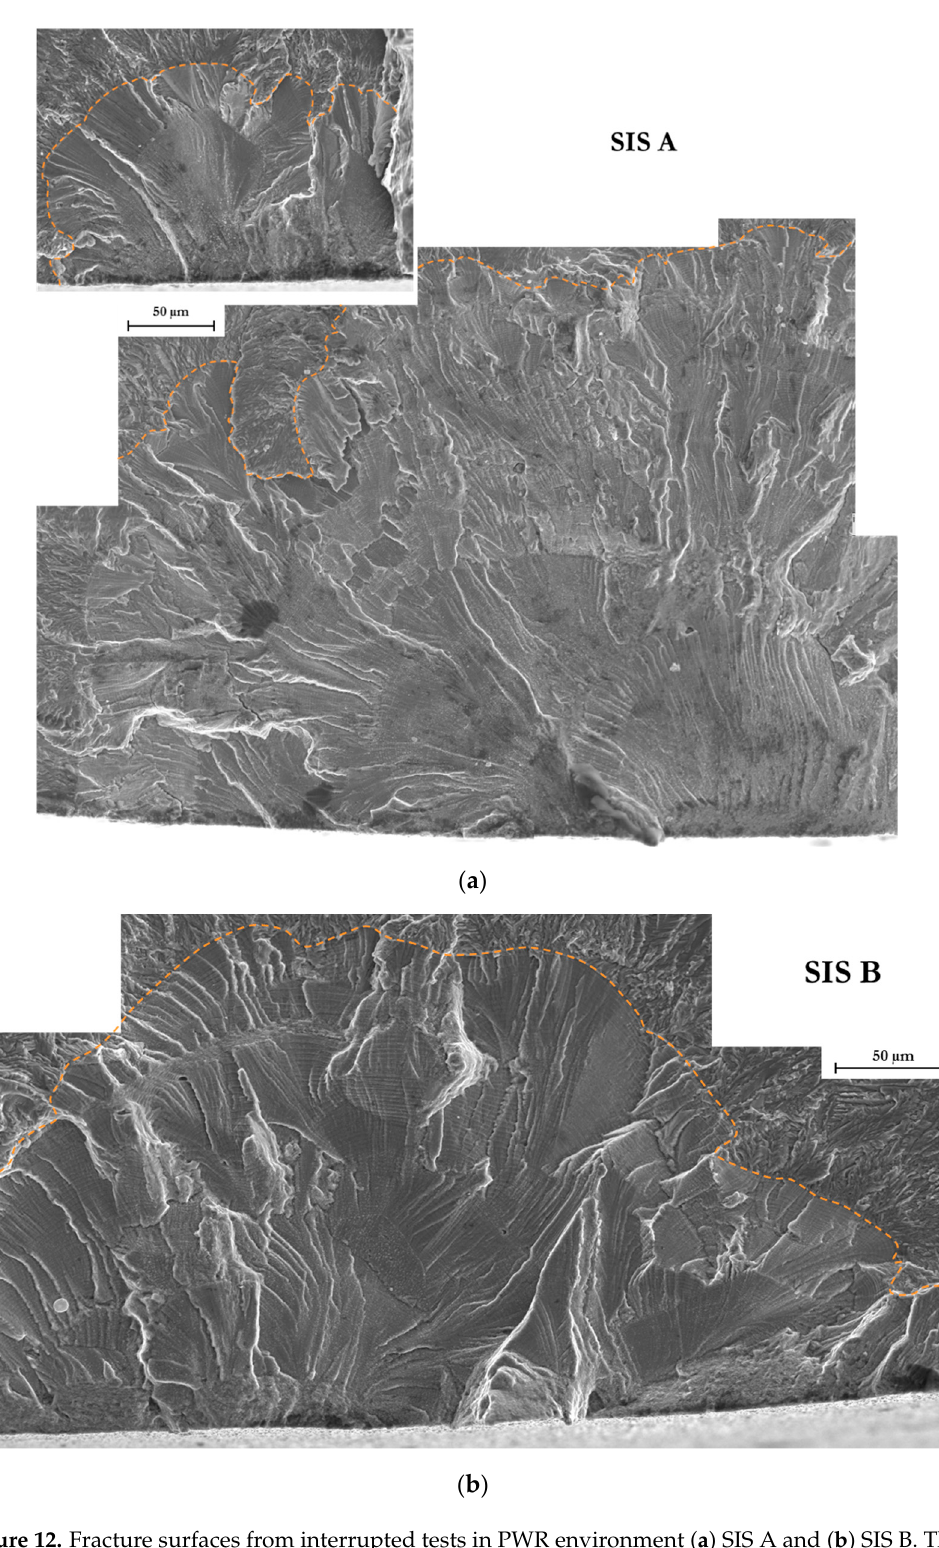
Figure 12. Fracture surfaces from interrupted tests in PWR environment ( a ) SIS A and ( b ) SIS B. The dotted lines correspond with the crack front at the transition between LCF and HCF loadings.